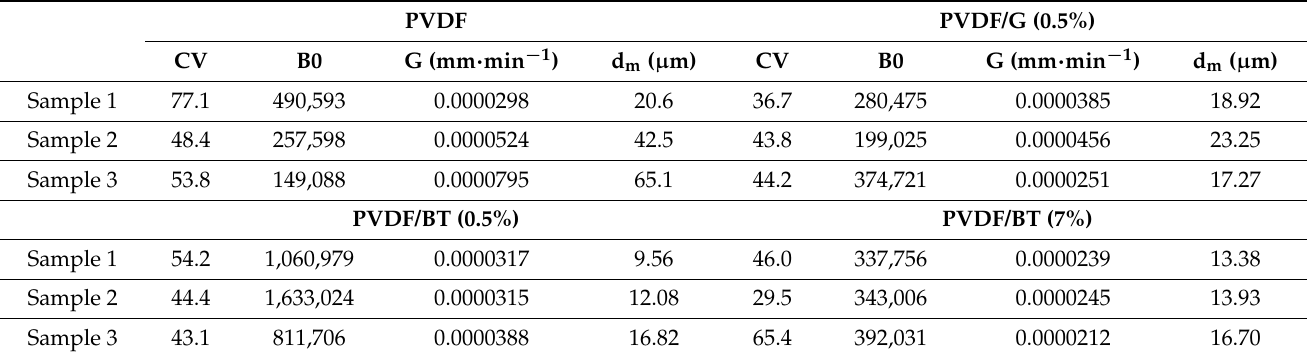
Table 3. NaCl crystal parameters obtained with PVDF-based membranes.